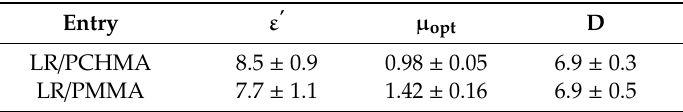
Table 1. Fitting parameters of the optical e ffi ciency data measured for Lumogen F Red 305 (LR) / poly (cyclohexylmethacrylate) (PCHMA) and LR / poly(methylmethacrylate) (PMMA) films with a thickness of 23 ± 6 µ